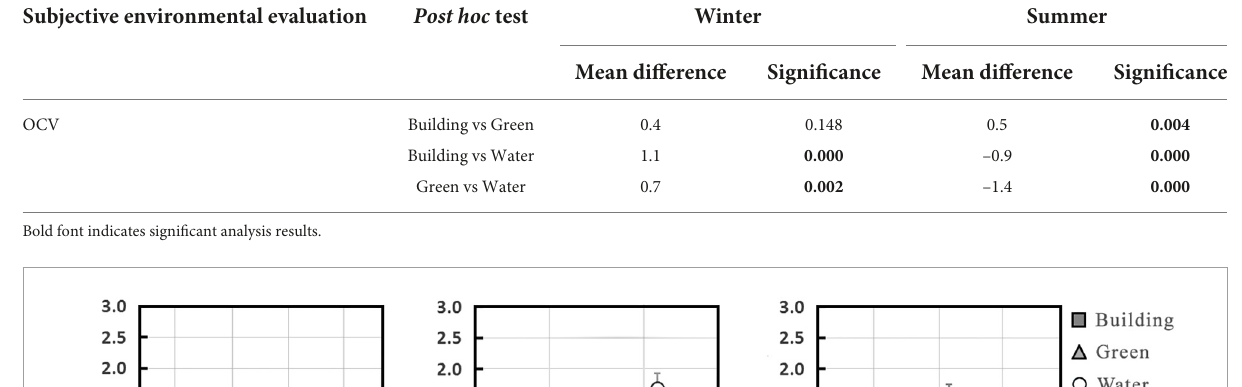
TABLE 7 Post hoc test of the differences in the OCV between landscapes.